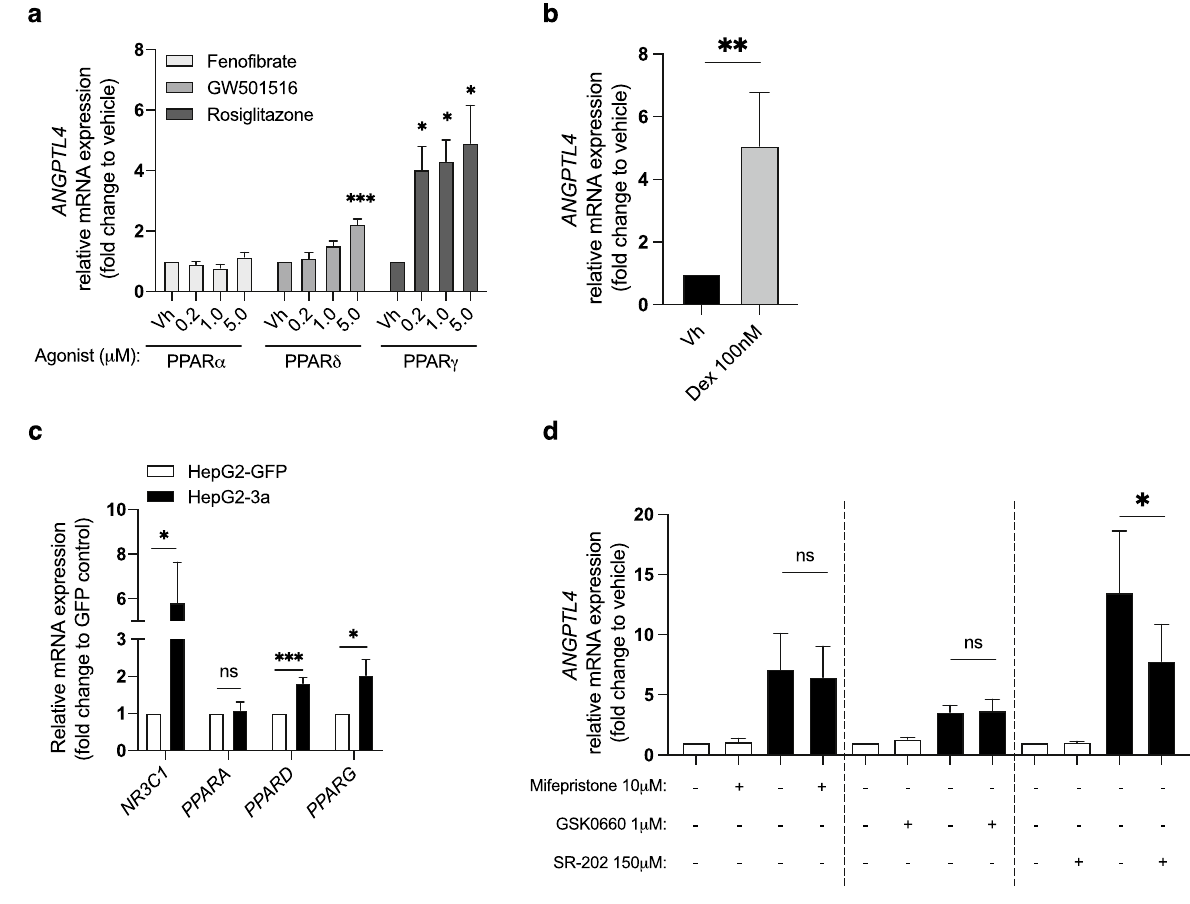
Figure 4. HCV induces upregulation of ANGPTL4 expression via PPARγ. ( a, b ) ANGPTL4 mRNA expression induced by PPAR ( a ) and GR agonists ( b ). ( c ) NR3C1 , PPARA , PPARD and PPARG mRNA expression in levels in HCV genotype 3a core-expressing HepG2 cells. ( d ) Effect of GR antagonist (mifepristone) and PPAR antagonist (SR-202) in the core-induced expression of ANGPTL4 . * p < 0.05, ** p < 0.01 and *** p <